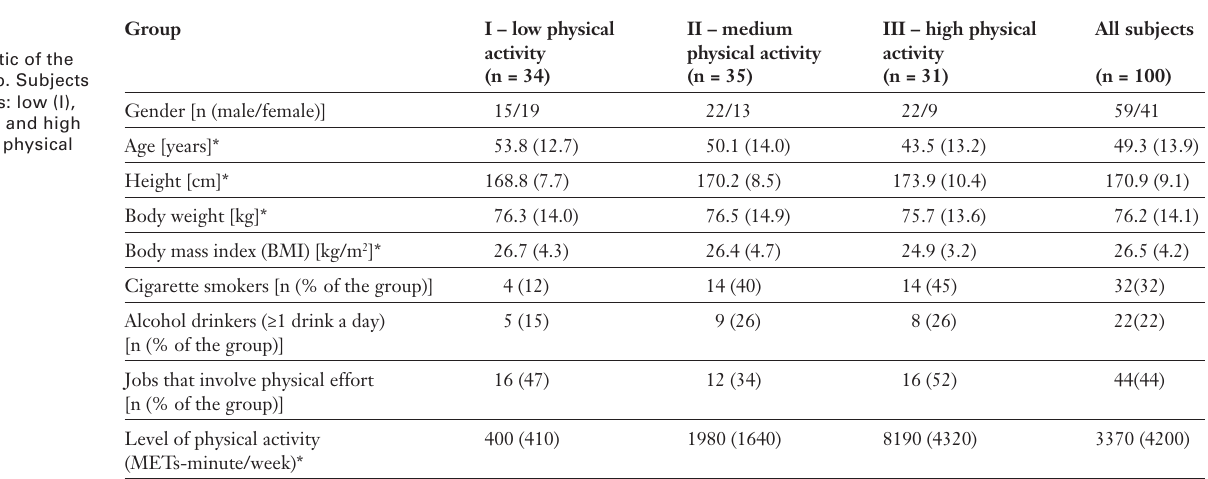
Characteristic of the study group. Subjects classified as: low (I), medium (II) and high (III) level of physical